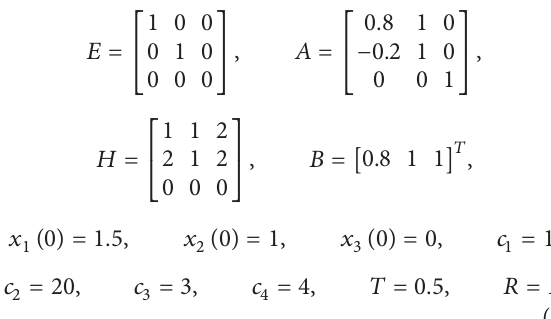
Figure 5: The evolution of E [𝑥 𝑇 (𝑡)𝐸 𝑇 𝑅𝐸𝑥(𝑡)] of the closed-system of